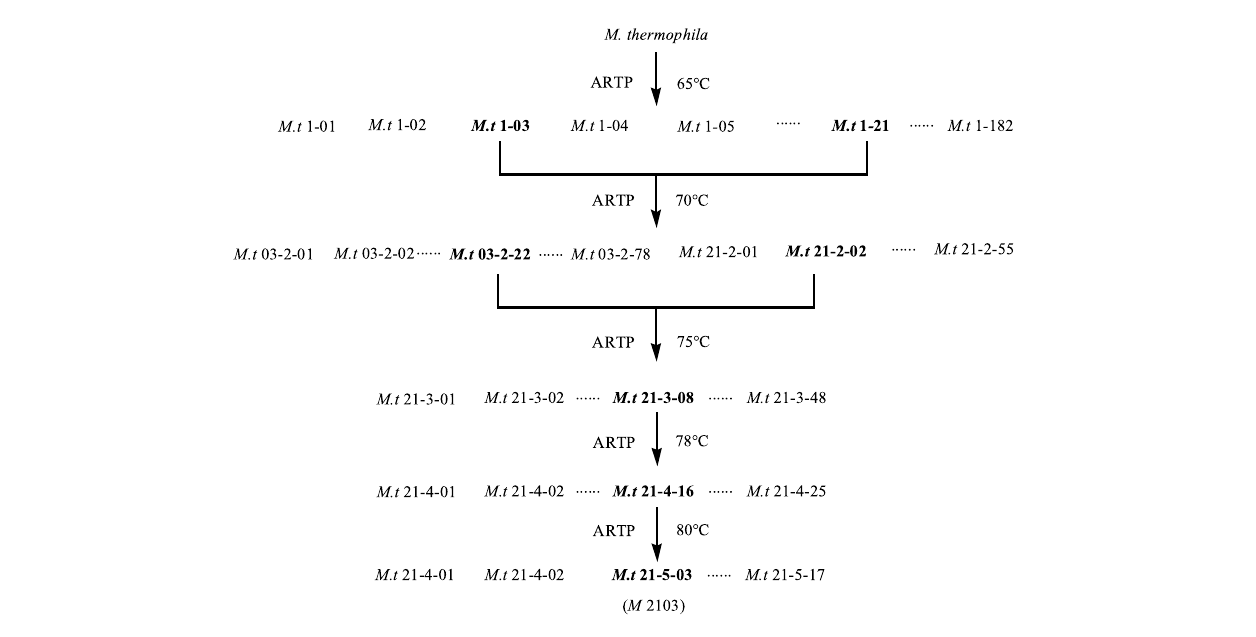
Screening spectrogram of the thermotolerant mutant M 2103. The fi rst group number for the mutant strains was the serial number of the obtained mutantafterthe fi rstmutagenesisbyARTP,thesecondgroupofnumberindicatethetimesofARTPmutagenesis,andthethirdgroupofnumberwastheserial number of the obtained mutant for this time of ARTP mutagenesis, and so on. The mutant strains with high xylanase activities after each mutagenesis were selectedforthenextmutation.After5mutagenesis,theculturetemperaturewasgraduallyincreasedfrom65 ° Cto80 ° C,andthethermostablemutant M 2013 with high activity of xylanase was fi nally